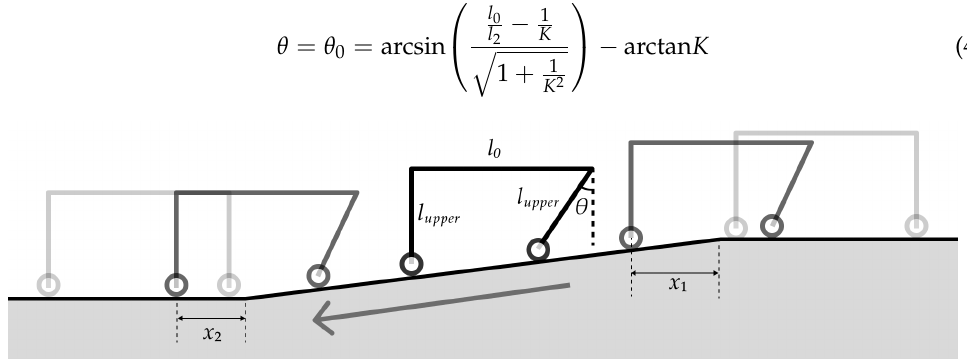
, the torso can keep its hori- 𝜃𝜃